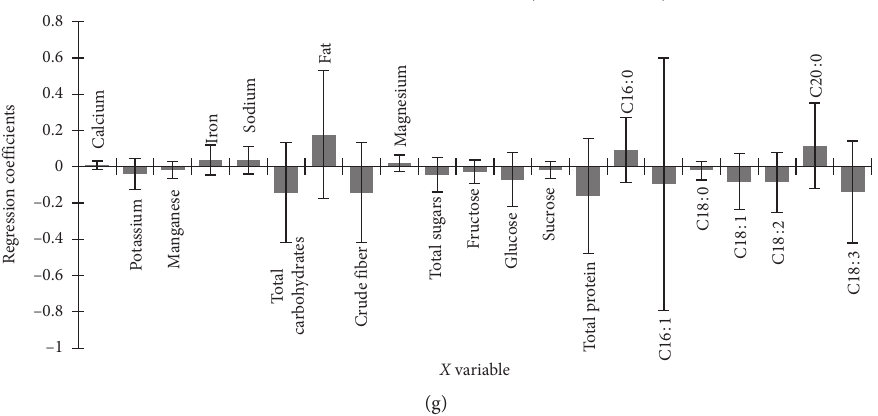
Figure 4: Regression coefficients and significant indications (shown in streaked bars) for substrate chemical composition variable: C16:0: palmitic acid, C16:1: palmitoleic acid, C18:0: stearic acid, C18:1: oleic acid, C18:2: linoleic acid, C18:3: linolenic acid, C20:0: arachidic acid, and M: mushroom. (a) C14:0M/standardized coefficients (95% conf. interval). (b) C16:0M/standardized coefficients (95% conf. interval). (c) C16:1M/ standardized coefficients (95% conf. interval). (d) C18:0M/standardized coefficients (95% conf. interval). (e) C18:1M/standardized coefficients (95% conf. interval). (f) C18:2M/standardized coefficients (95% conf. interval). (g) C18:3M/standardized coefficients (95% conf.